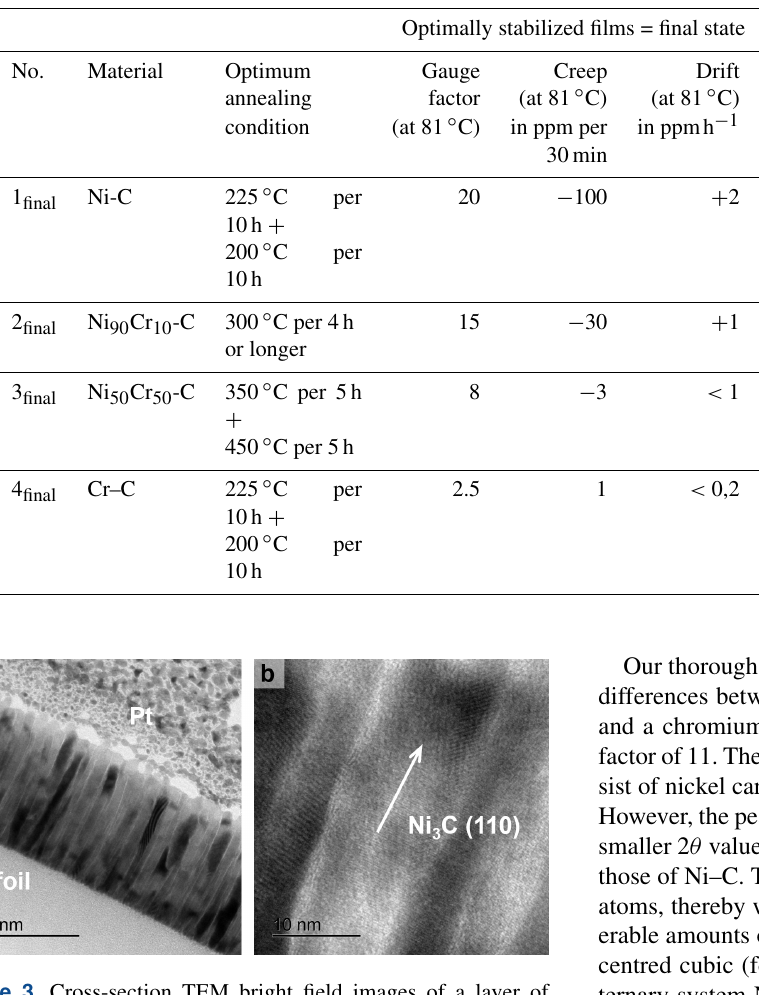
Figure 3. Cross-section TEM bright field images of a layer of Ni 90 Cr 10 -C. (a) as-deposited (sample 2 initial ) (b) after heat treat- ment of 300 ◦ C per 4h (sample 2 final ) in high-resolution